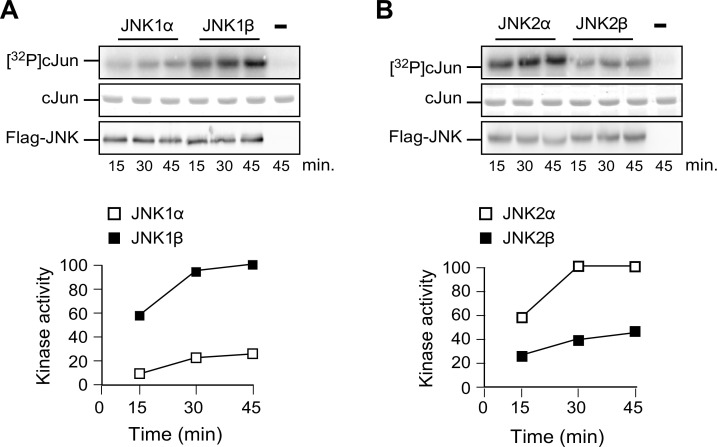
Comparison of JNKα and JNKβ protein kinase activity in vitro.(A) Flag-tagged JNK1α1 and JNK1β1 expressed in 293T cells were isolated by immunoprecipitation using anti-Flag (M2) agarose. Protein kinase activity was measured with an in vitro assay using GST-cJun and [γ-32P] ATP as substrates. The amount of JNK in each assay was examined by immunoblot analysis. The amount of phosphorylated cJun was examined by Phosphorimager analysis. (B) In vitro kinase assays were performed using Flag-tagged JNK2α2 and JNK2β2.